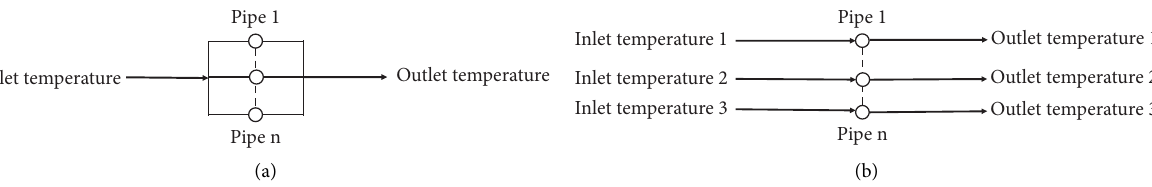
Figure 8: Two operation strategies for the BHE array: (a) SHL mode and (b) SIT mode.